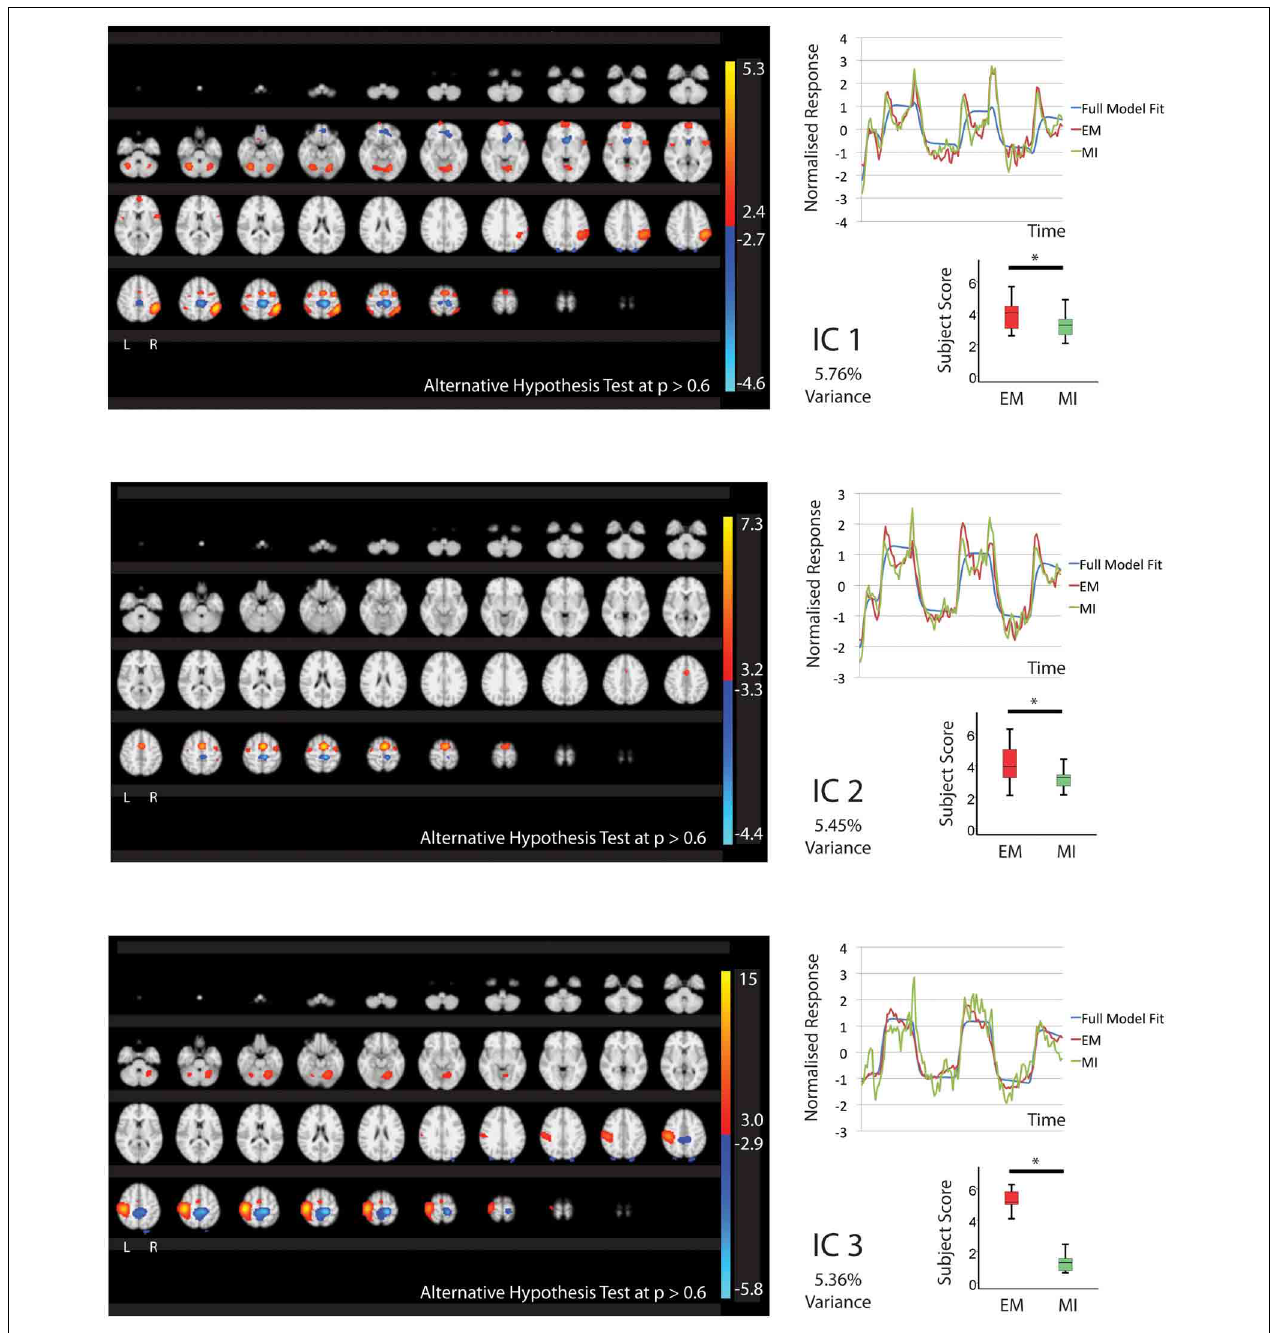
FIGURE 1 | The figures show the involvement of each IC across the whole brain with a standard threshold of p > 0 . 6 (alternative Hypothesis test) and the variance is accounts for out of the total explained variance. The scales show the transformed z -score, orange is activation, blue is deactivation. The normalized time course response is shown for each task and the full model fit (Full model fit = blue,